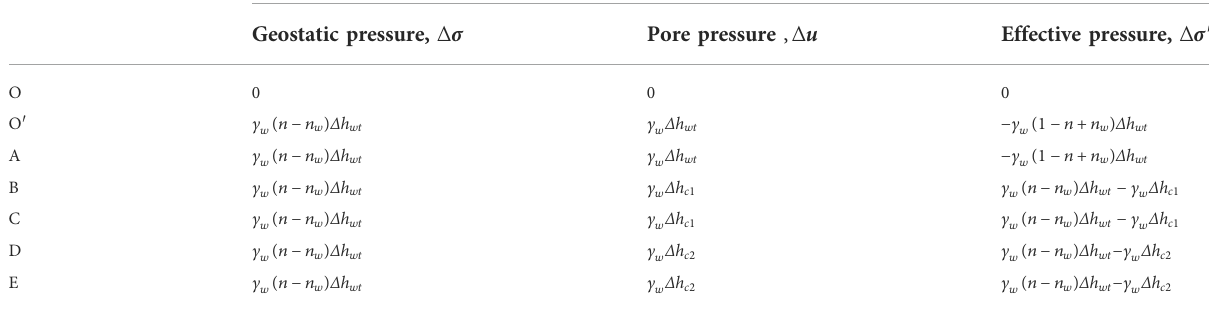
TABLE 1 Variation of stresses due to water level changes in the aquifer.